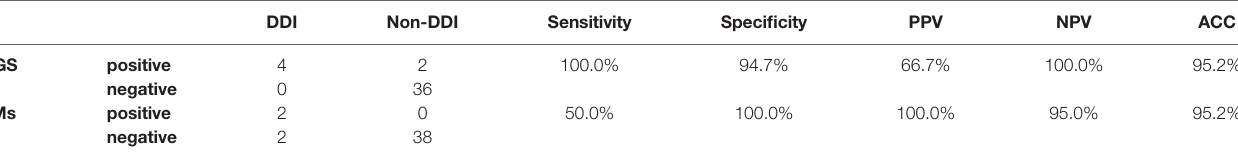
TABLE 3 | Comparison of sensitivity and speci fi city between NGS and TMs in diagnosis of